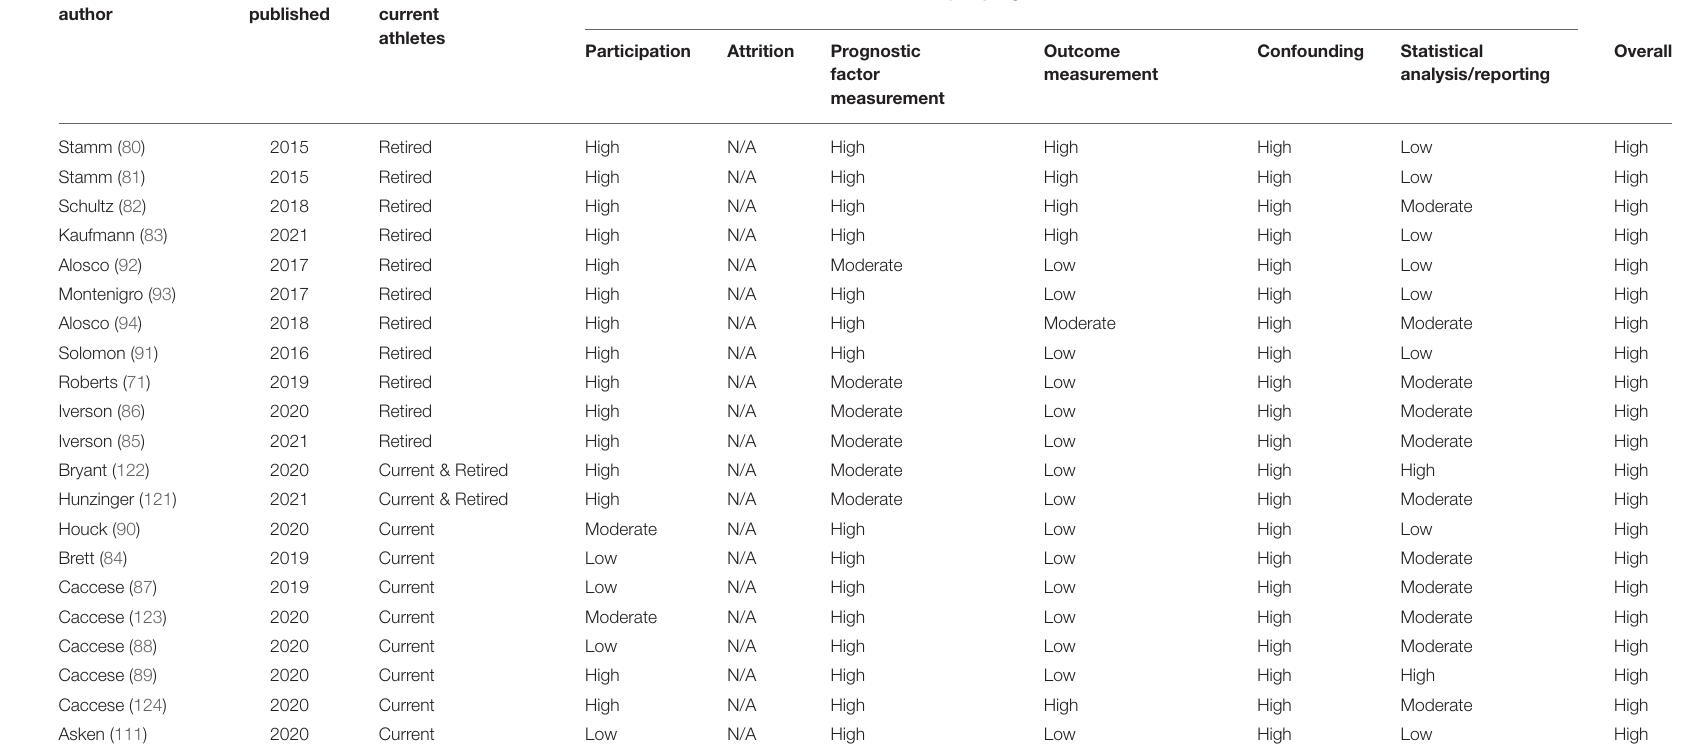
TABLE 3 | Quality in prognosis studies tool ratings (risk for bias